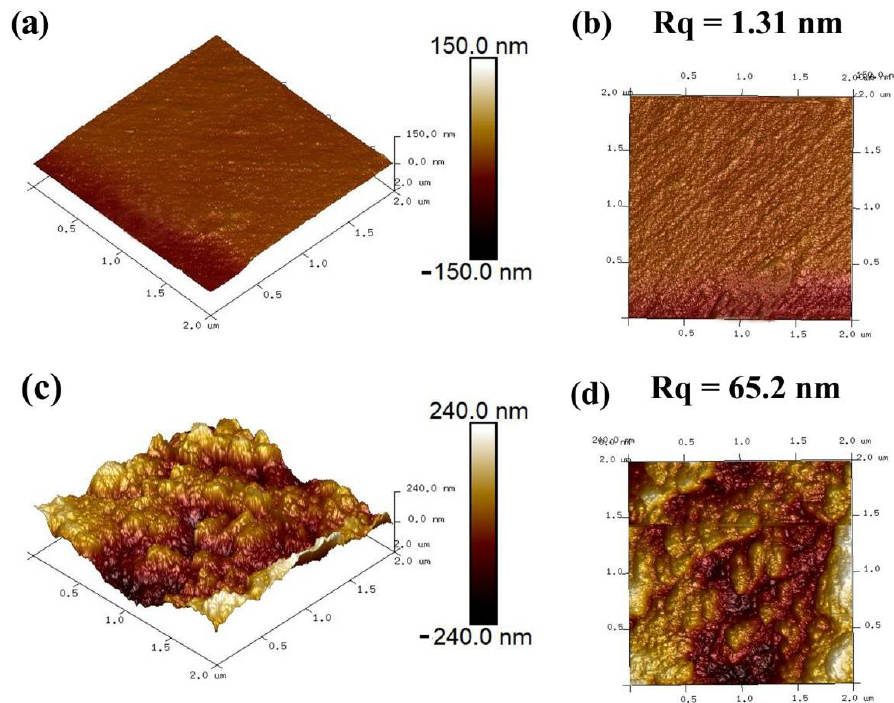
Figure 4. Atomic-force microscopy 3D and 2D images of ( a , b ) adhesive-coated filter paper and ( c , d ) P 40 –P 4 –P 0.4 adhesive-coated filter paper.